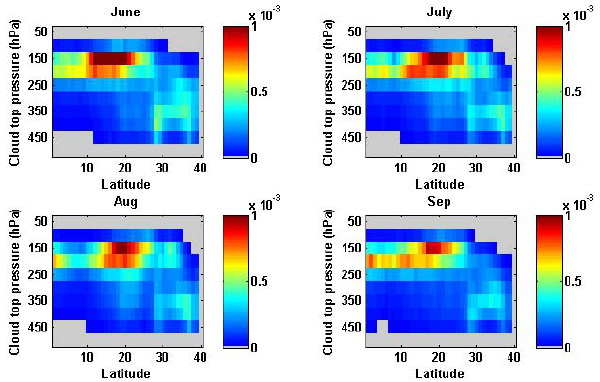
Fig. 9. The relative fraction of clouds as shown in Fig. 8 with optical thickness greater than 23 (i.e. only deep convective clouds as per the definition by the ISCCP).